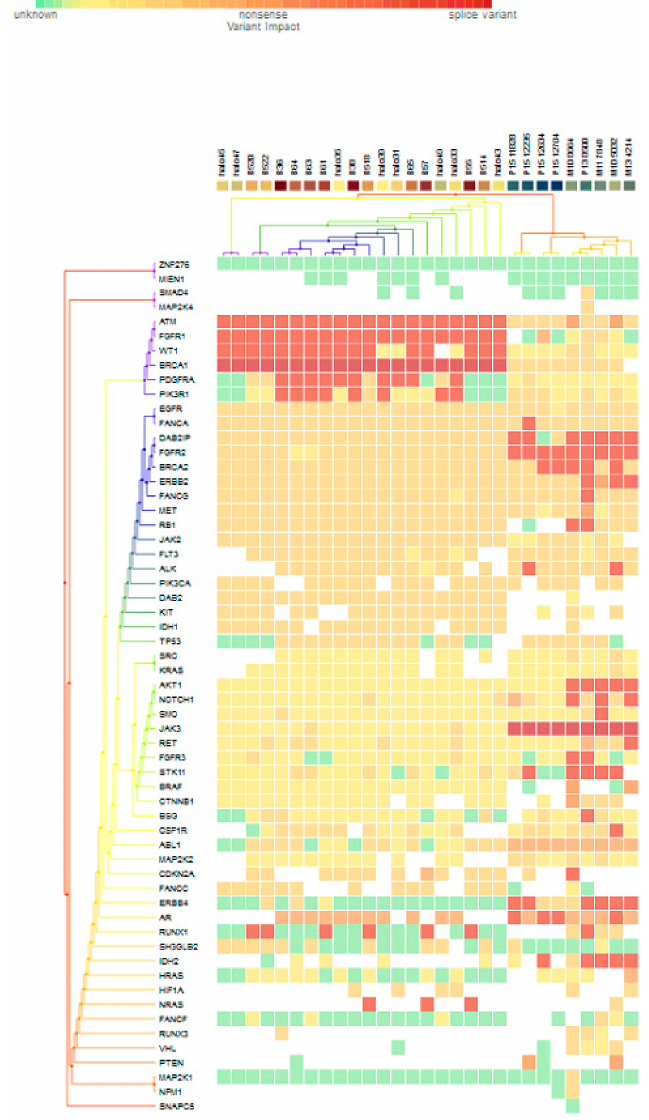
Figure 3. Heat map for 31 HR+/HER2 − subtype breast cancers. The variants impacted for 31 HR+/HER2 − breast cancers were INDELs. Frameshift: ATM, FGFR1 (20), WT1 (16), PDGFRA (10), PIK3R1 (8), FANCA (1), DAB2IP (7), FGFR2 (9), BRCA2 (5), ERBB2 (3), FANCG (1), RB1, ALK (2), AKT1